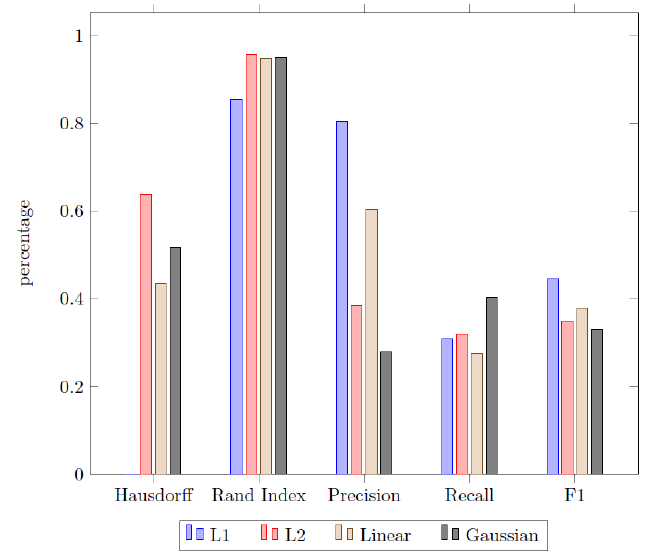
Figure 11. Comparison of exemplary cost functions.